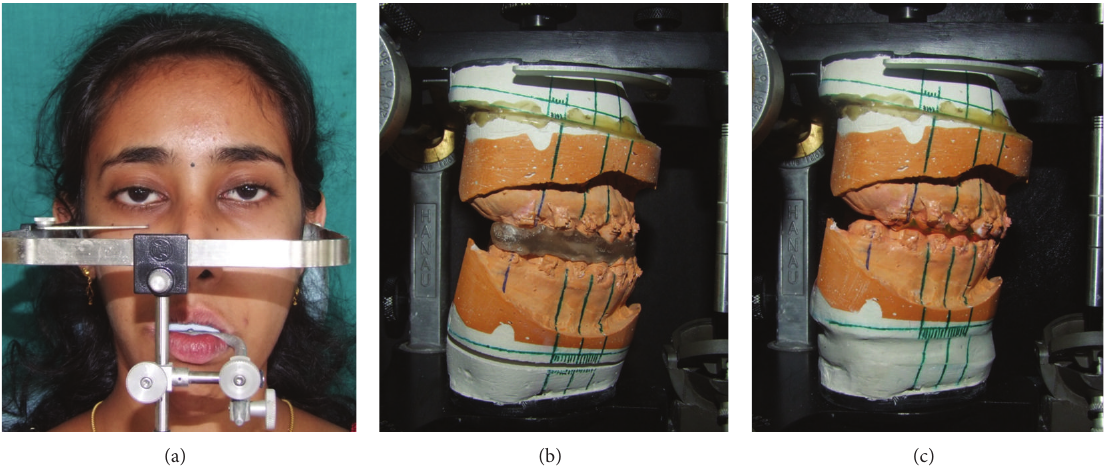
Figure 14: (a) facebow transfer and model surgery with (b) intermediate and (c) final occlusal splints.